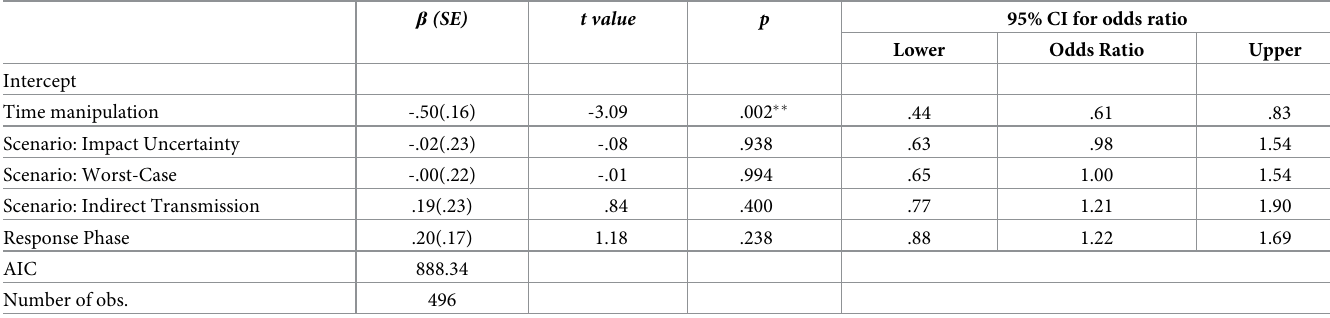
Table 1. Estimates of the ordinal logistic regression